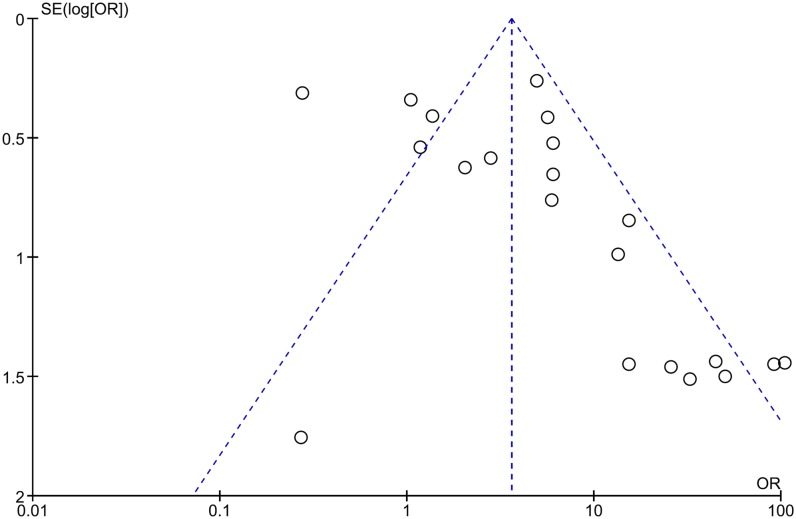
Funnel plot of the result of pooled analysis.